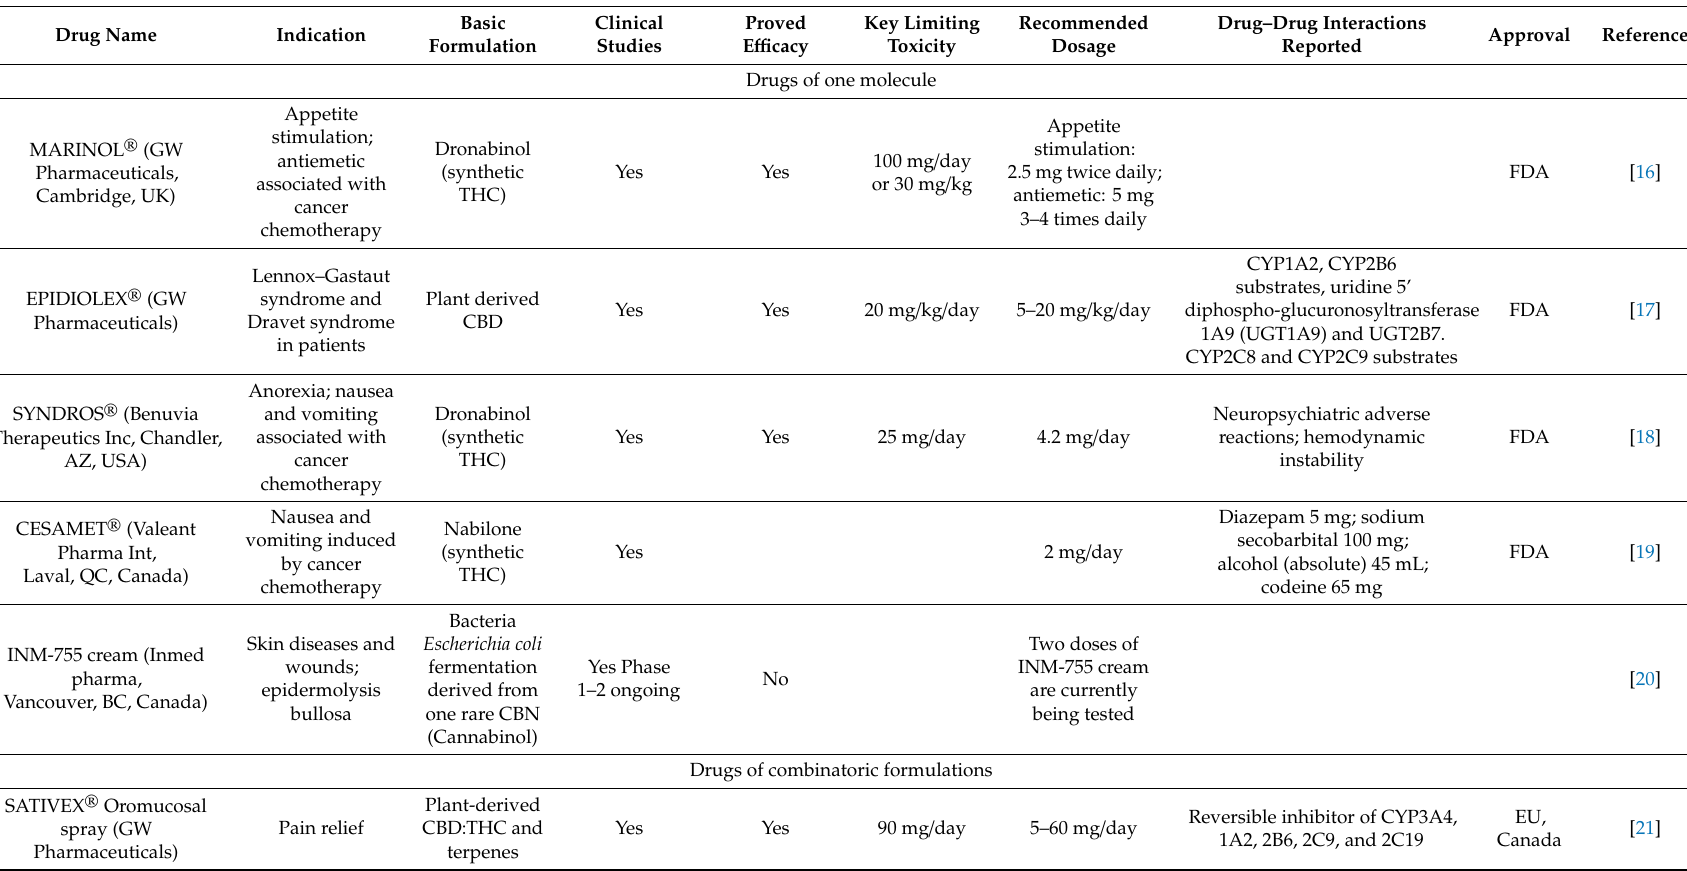
Table 1. Cannabis-inspired or -based medicines available today and their pharmaceutical status. FDA, Food and Drug Administration; THC, ∆ 9-tetrahydrocannabinol; CBD, cannabidiol; CBN, cannabinol; CYP, Cytochrome P450; EU, European Union; UGT, uridine 5 (cid:48)